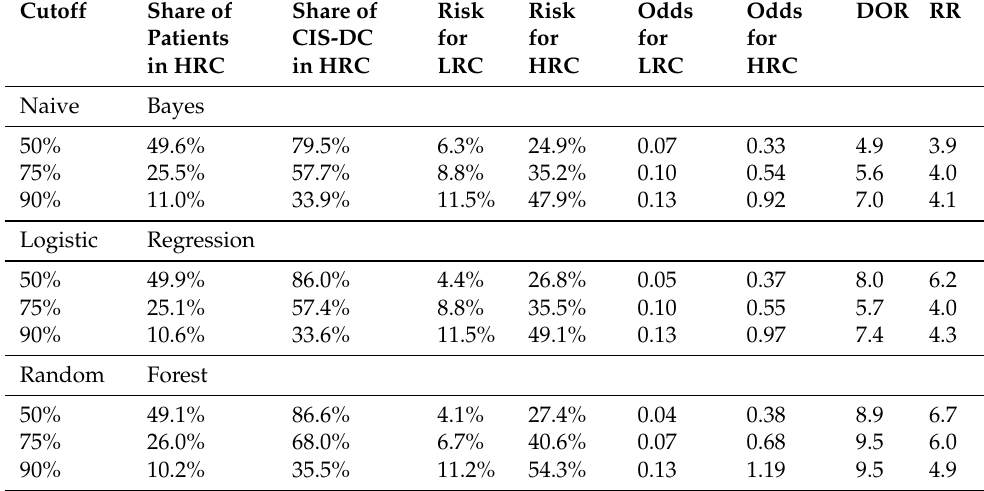
Table 4. Cross-validated results for the three classifiers, built using the seven selected markers. Stratified 5-fold cross validation, repeated 30 times, was used. Column headings are as in Table 3. Please note that the observed inconsistency between the cutoff and the share of patients in the HRC stems from the application of cross validation—the share is averaged over all folds from all iterations, while the cutoff is established using the entire dataset a